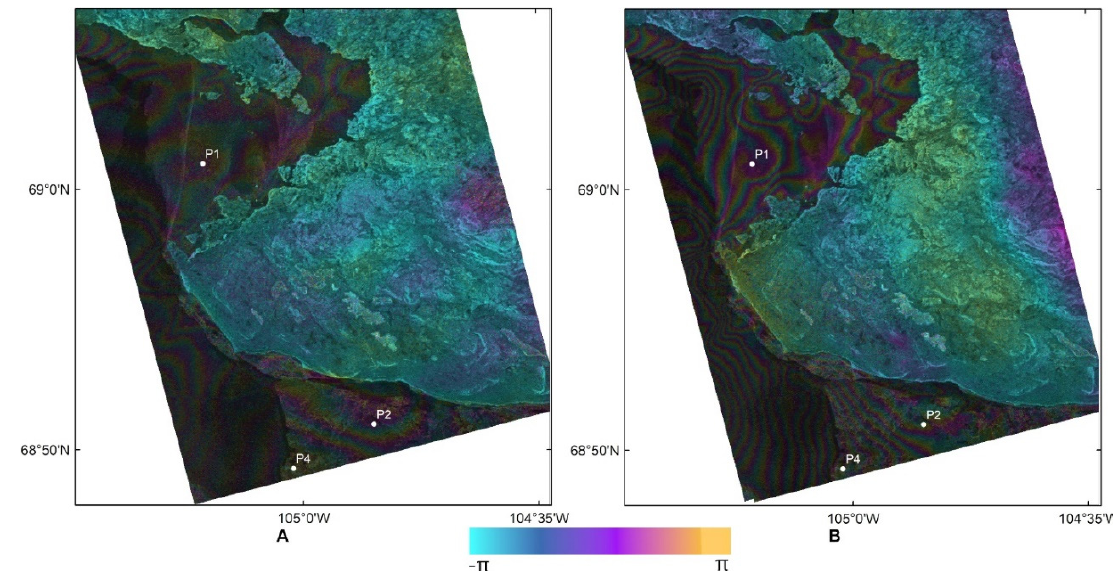
Figure 4. Radarsat-2 FQ13 interferograms of HH polarization. ( A ): 28 March–21 April, ( B ): 21 April–15 May. One cycle of color ( −π to π ) representing 2.8 cm in range change.